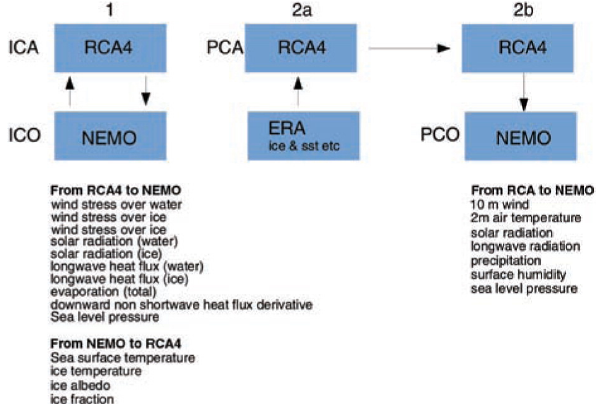
Figure 3. Mass, momentum and heat exchange as realized in the atmosphere–ocean model RCA4-NEMO. The abbreviations used in the figure are as follows: ICA – interactively coupled atmosphere, PCA – passively coupled atmosphere, ICO – interactively coupled ocean and PCO – passively coupled ocean. Source: Gröger et al.